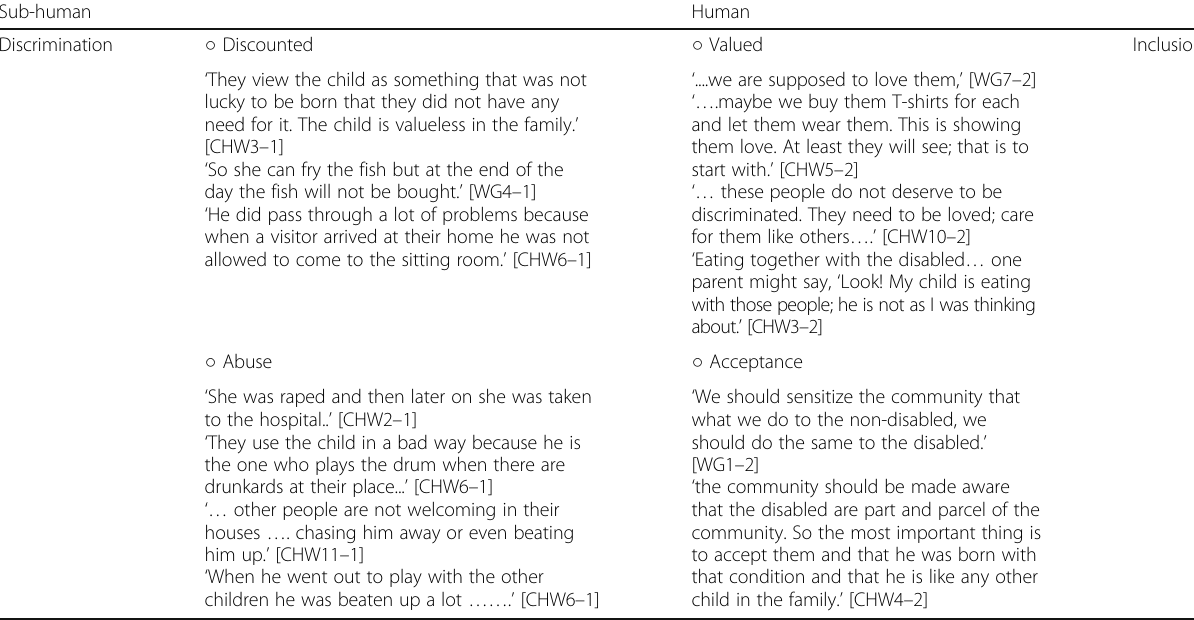
Table 5 Sub-human vs Human construct: Discrimination √ Inclusion Sub-human Human